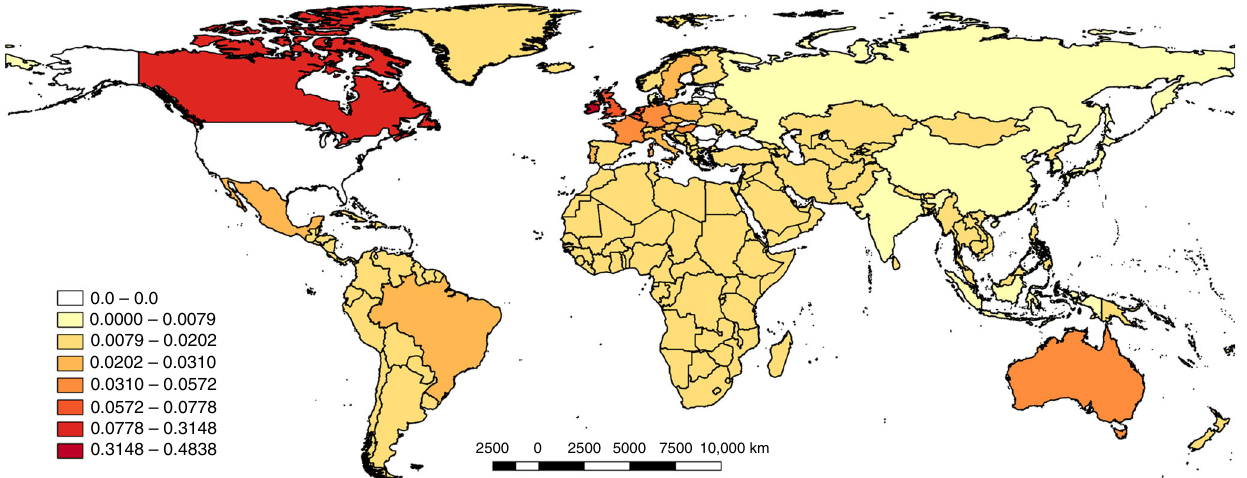
Fig. 3 2009 weight of US-MNEs ’ carbon footprint on producer responsibility of the host country (producer footprint). This study covers the following 27 EU countries and 13 other major countries (using ISO 3166 – 1 alfa-3 country codes): AUS, AUT, BEL, BGR, BRA, CAN, CHN, CYP, CZE, DEU, DNK, ESP, EST, FIN, FRA, GBR, GRC, HUN, IDN, IND, IRL, ITA, JPN, KOR, LTU, LUX, LVA, MEX, MLT, NLD, POL, PRT, ROU, RUS, SVK, SVN, SWE, TUR, TWN, and USA. The remaining non-covered part of the world is called ROW. See Supplementary Data 3. This map has been created using QGIS Geographic